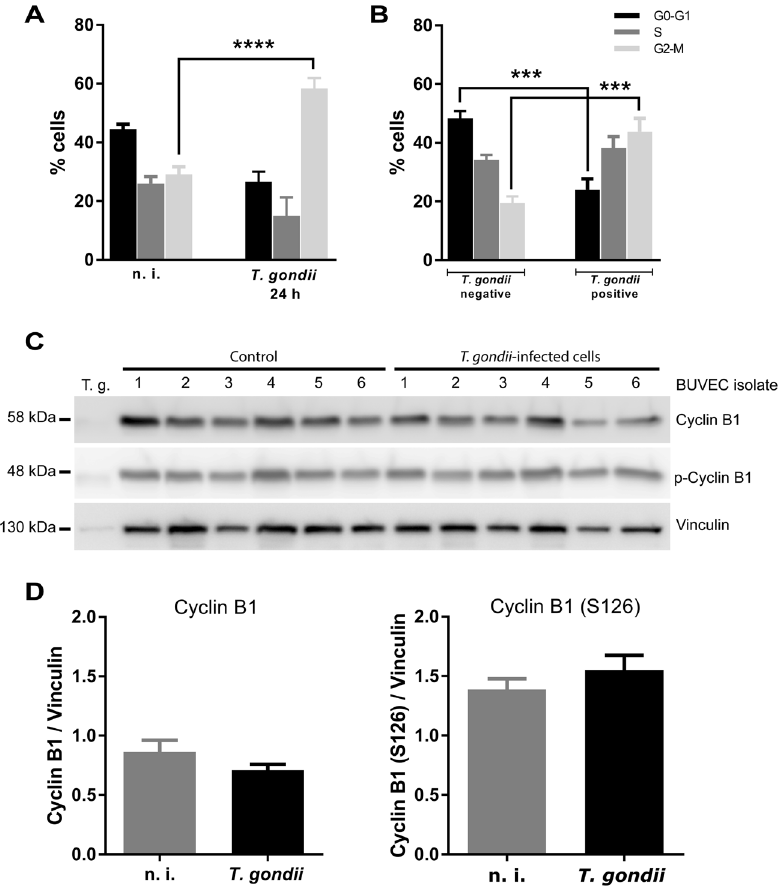
Figure 2. Distribution of cell cycle phases in T. gondii -infected BUVEC and control cells and expression/ phosphorylation of cyclin B1 in infected cells. ( A ) BUVEC were infected with T. gondii tachyzoites and examined for DNA content one day after infection applying FACS analyses. Therefore, the total amount of cells with one (G-phase) or two copies (G2-phase) of the genome was plotted as a percentage of the total cells vs DNA amount. ( B ) Analysis of T. gondii -infected cells vs non-infected cells originating from the same (infected) cell layer was done using an specific antibody against T. gondii tachyzoites for splitting both population. ( C , D ) Analysis of cyclin B1 expression and phosphorylation in T. gondii -infected BUVEC. Six biological replicates of BUVEC were analyzed by Western blotting ( C ) for the expression of cyclin B1 and its phosphorylated form (S126). For control, pure T. gondii tachyzoites were also analyzed. The density of the protein signals was quantified and graphed as ratio relative to vinculin as housekeeping protein ( D ). Bars represent the median ± SEM. Nonparametric one-way ANOVA, *** p ≤ 0.001, *** p <